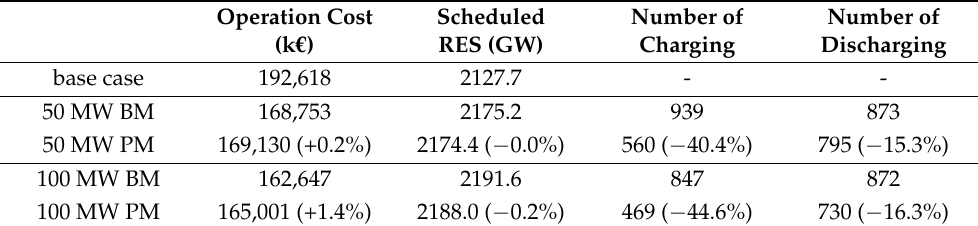
Table 3. Yearly Results of 2030.